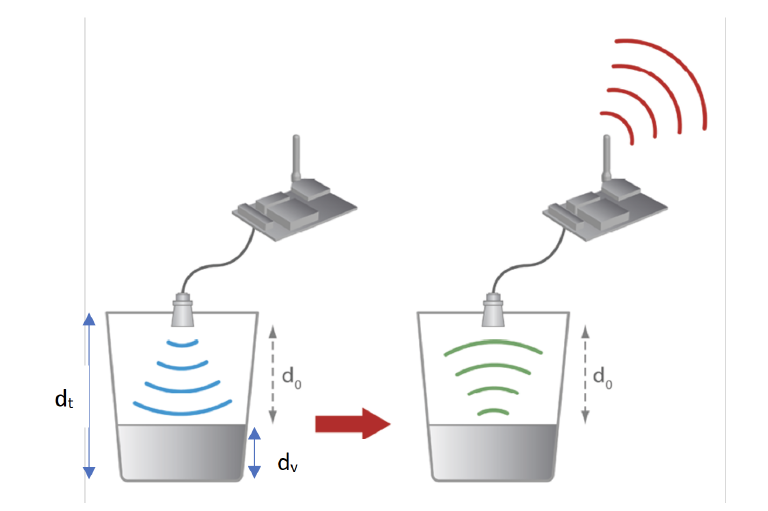
Figure 7. Ultrasound sensor measurement